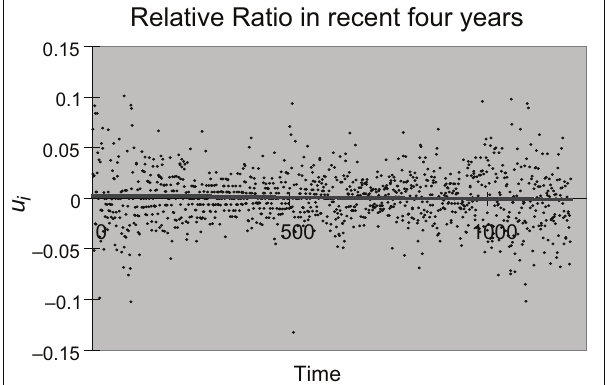
Relative Ratio in recent four